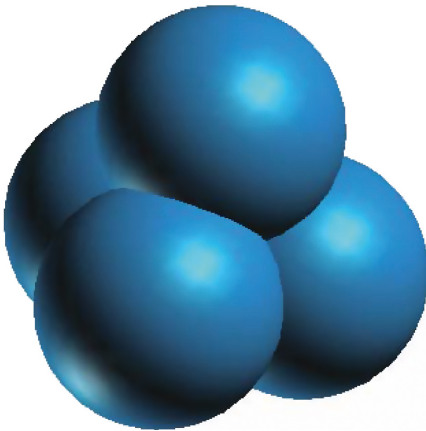
Figure 4: Clump discrete Table 1: Mesoparameters used in the simulation.